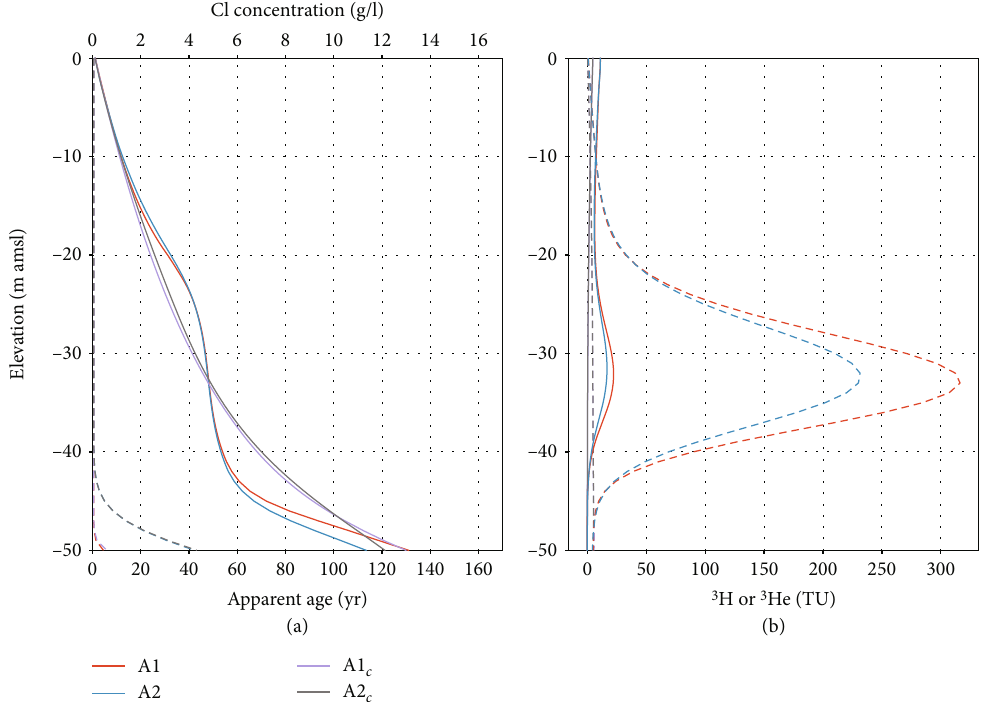
Figure 7: (a) Apparent age τ (solid lines) and chloride concentration (dashed lines) for simulations A1 and A2 and (b) the 3 H (solid lines) and 3 He (dashed lines) concentration versus elevation at the end of the simulation period (31 December 2013). The location of this pro fi le is indicated in Figure 5. Results are shown both for a constant 3 H input of 9TU (as indicated by the subscript c) and for the 3 H input according to the curve in Figure 2(b).